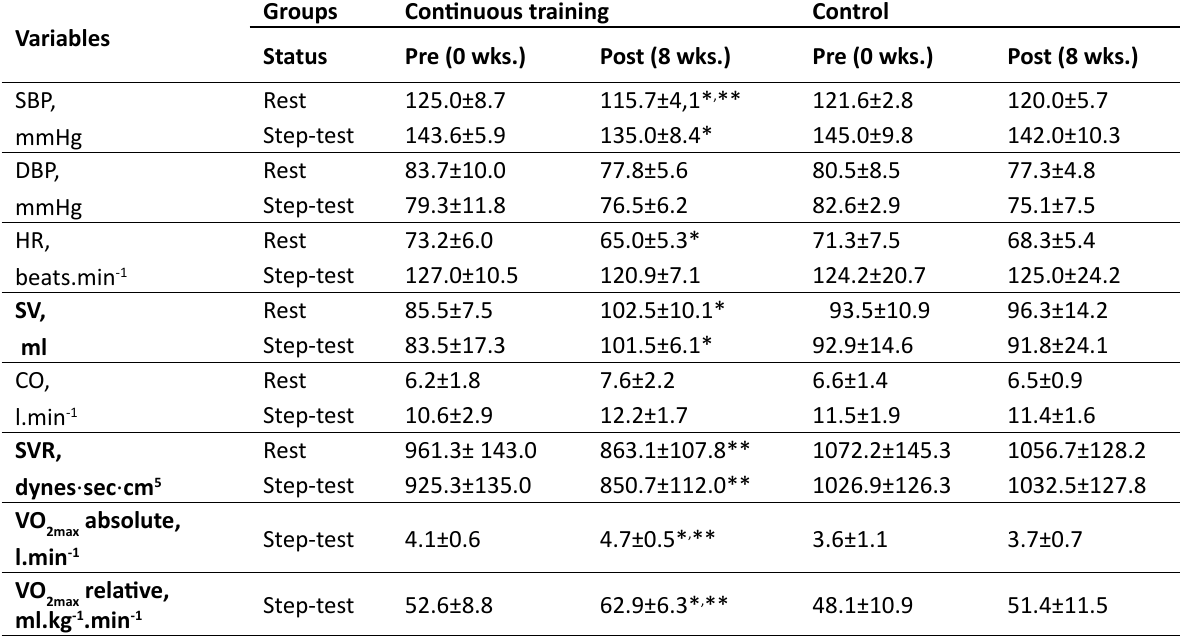
Table 2. Values of central hemodynamic variables in the training and control groups